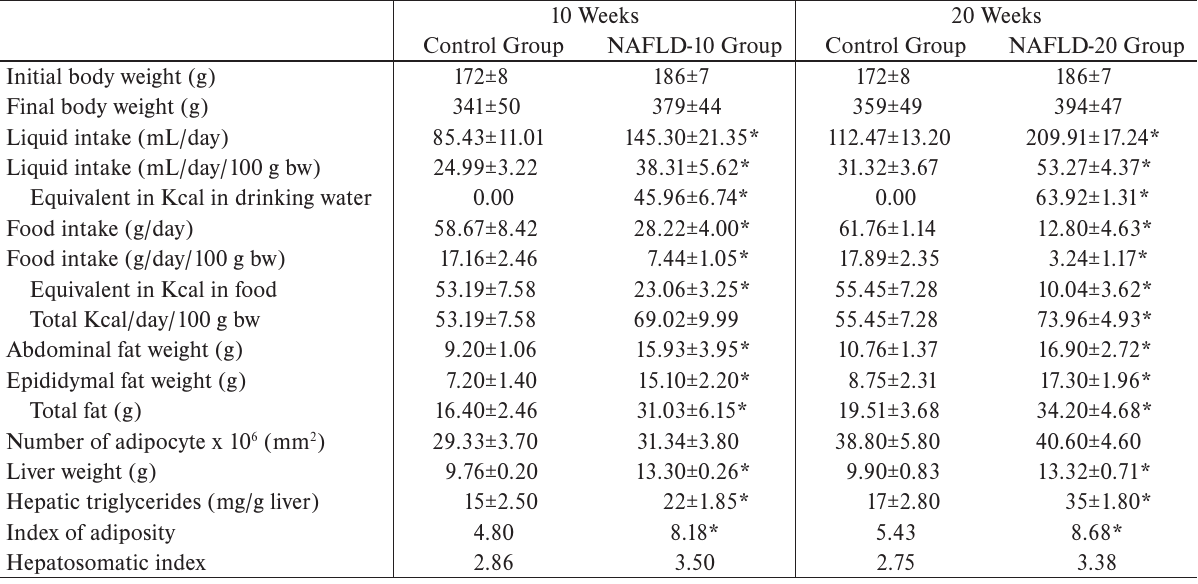
Table 1. Caloric consumption parameters, fat and liver weight in sucrose-fed NAFLD and Control groups.